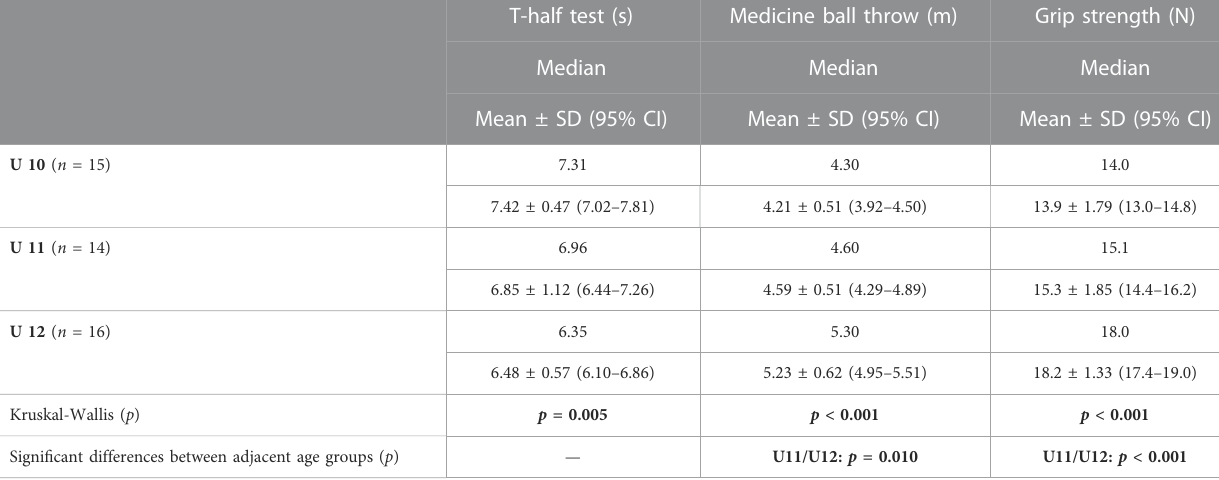
TABLE 6 Agility, throwing performance and grip strength in relation to age